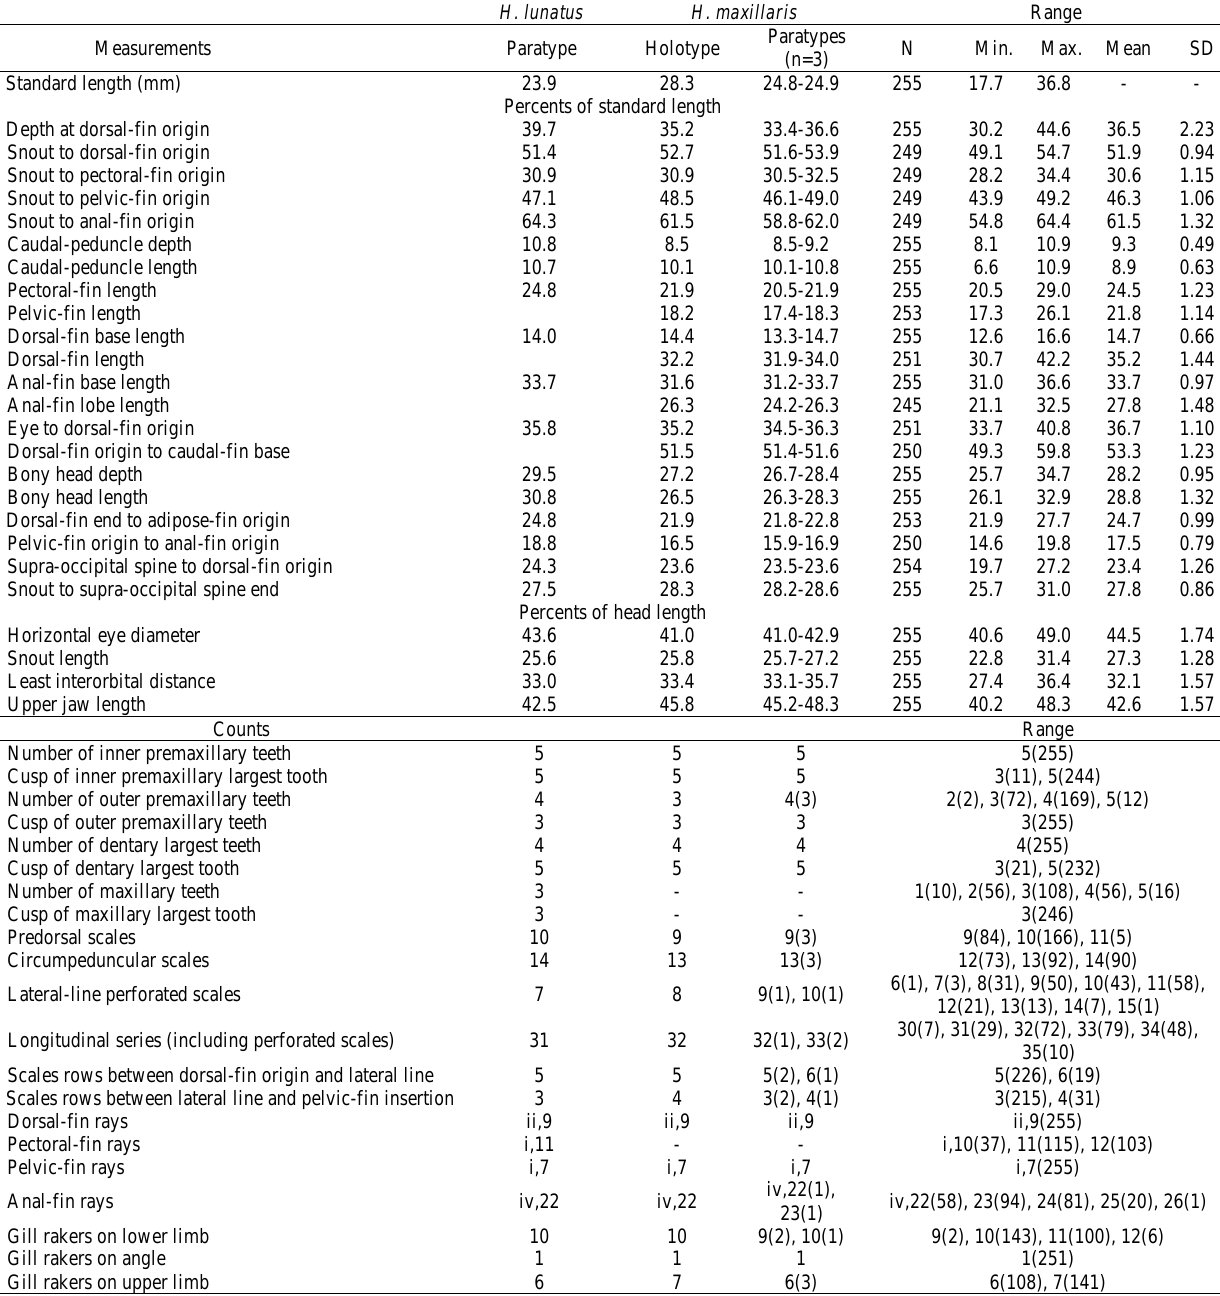
Table 2. Morphometric and meristic data of Hemigrammus lunatus (CAS 42679, paratype; Hyphessobrycon maxillaris , ANSP 53660, holotype and ANSP 53661, paratypes) and from non-type specimens. N = number of specimens; SD = standard